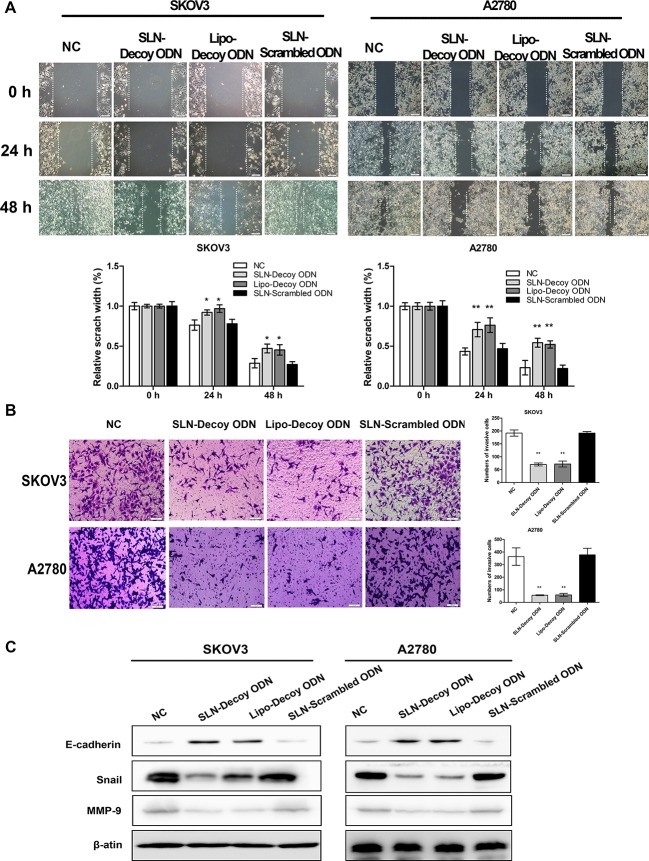
SLN-STAT3 decoy ODN complexes inhibit migration and invasion of ovarian cancer cells.(A) SLN-decoy ODN exhibited slower wound recovery at 24 and 48 hours after wounding compared with the NC and scrambled ODN groups. (B) A transwell invasion assay showed that SLN-decoy ODN inhibited cell invasion. At 48 hours after transfection, cells were reseeded to the upper transwell chamber for 24 hours and stained with crystal violet. (C) Western blot analysis showed that SLN-decoy ODN increased E-cadherin expression and reduced Snail and MMP9 expression. The data are expressed as the means ± SD of three independent experiments, * P < 0.05, ** P < 0.01 compared with NC.